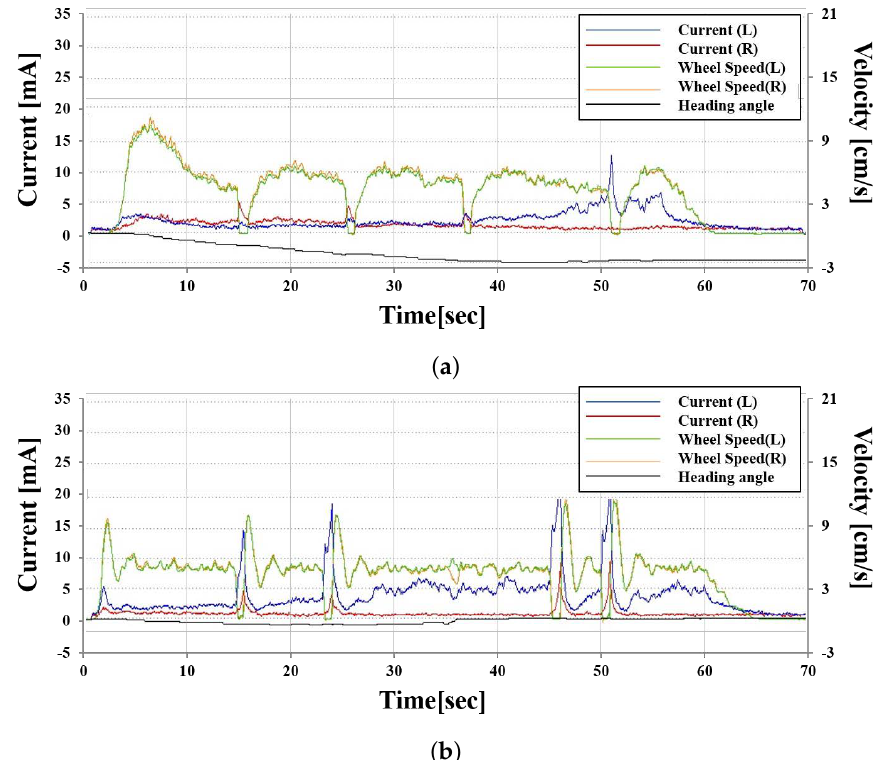
Figure 13. Experimental results of trajectory tracking control. ( a ) Backstepping control; ( b ) PD-backstepping